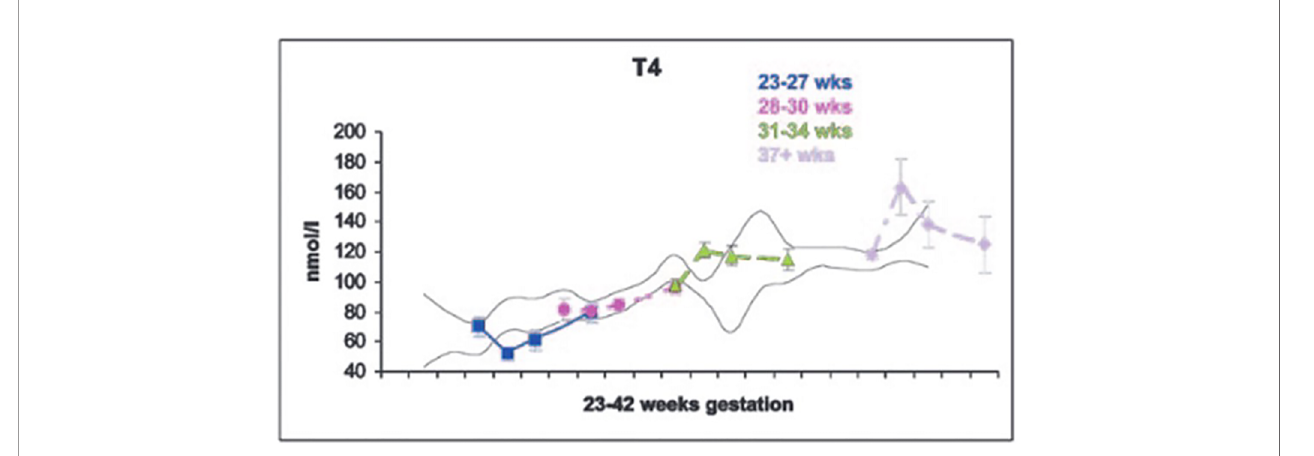
FIGURE 2 | Serum T4 levels in cord blood, and at 7, 14 and 28 days of life in neonates of 23-27, 28-30, 31-34, and 37+ weeks gestation. With permission from Williams FL, Simpson J, Delahunty C, et al. Developmental trends in cord and postpartum serum thyroid hormones in preterm infants. J Clin Endocrinol Metab 2004; 89:5314-5320